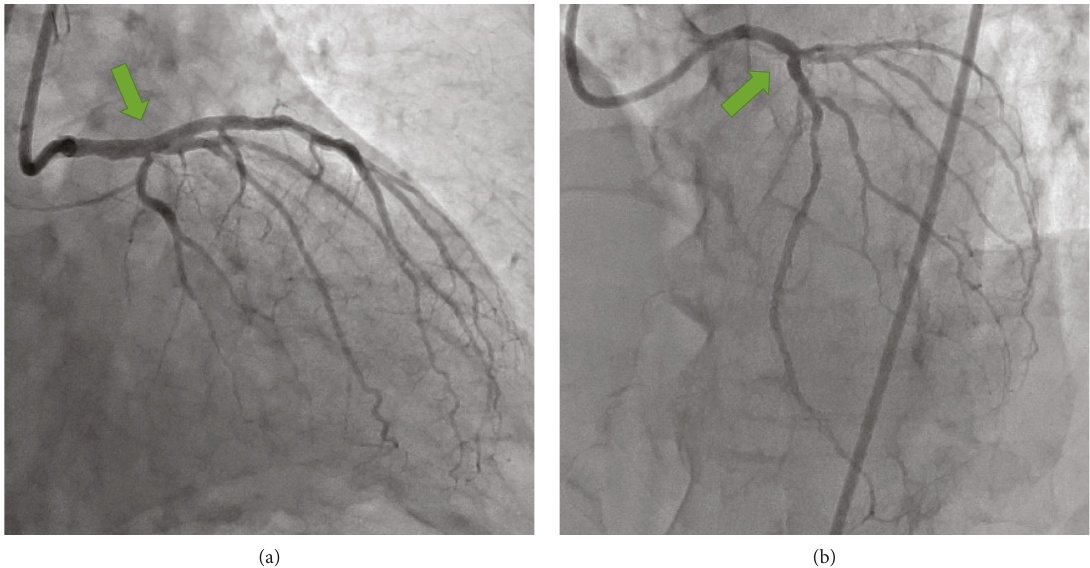
Figure 3: Final coronary angiogram of the (a) right anterior oblique caudal view and (b) left anterior oblique cranial view showed excellent results without any complications including side branch narrowing or occlusion (green